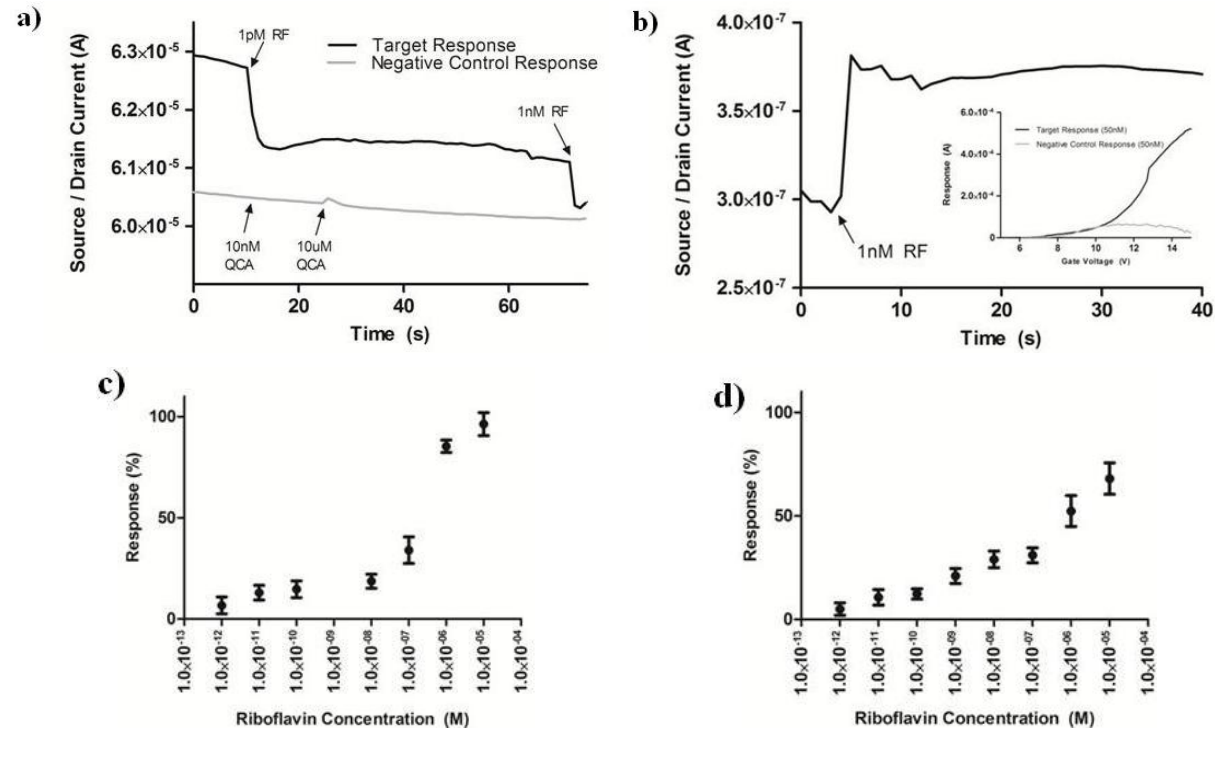
Figure 4. Sensor performance: ( a ) Real-time measurement of OFF state sensor response to the target riboflavin and negative control QCA via I vs . Time (s) with V = 0.2 V and SD SD V = 8 V. ( b ) Real-time ON state sensing via I vs . time (s) for 10 nM exposure to GS SD riboflavin. Inset shows I vs . V sensor response to 10 µM riboflavin and 10 µM negative SD G control QCA. ( c ) Signal dependence vs . riboflavin concentration (M) for OFF state sensing scheme. ( d ) Signal dependence vs. riboflavin concentration (M) for ON state sensing